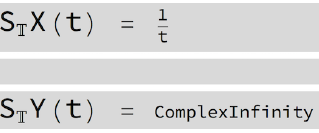
Figure 17. Output given by the [SInt] algorithm.